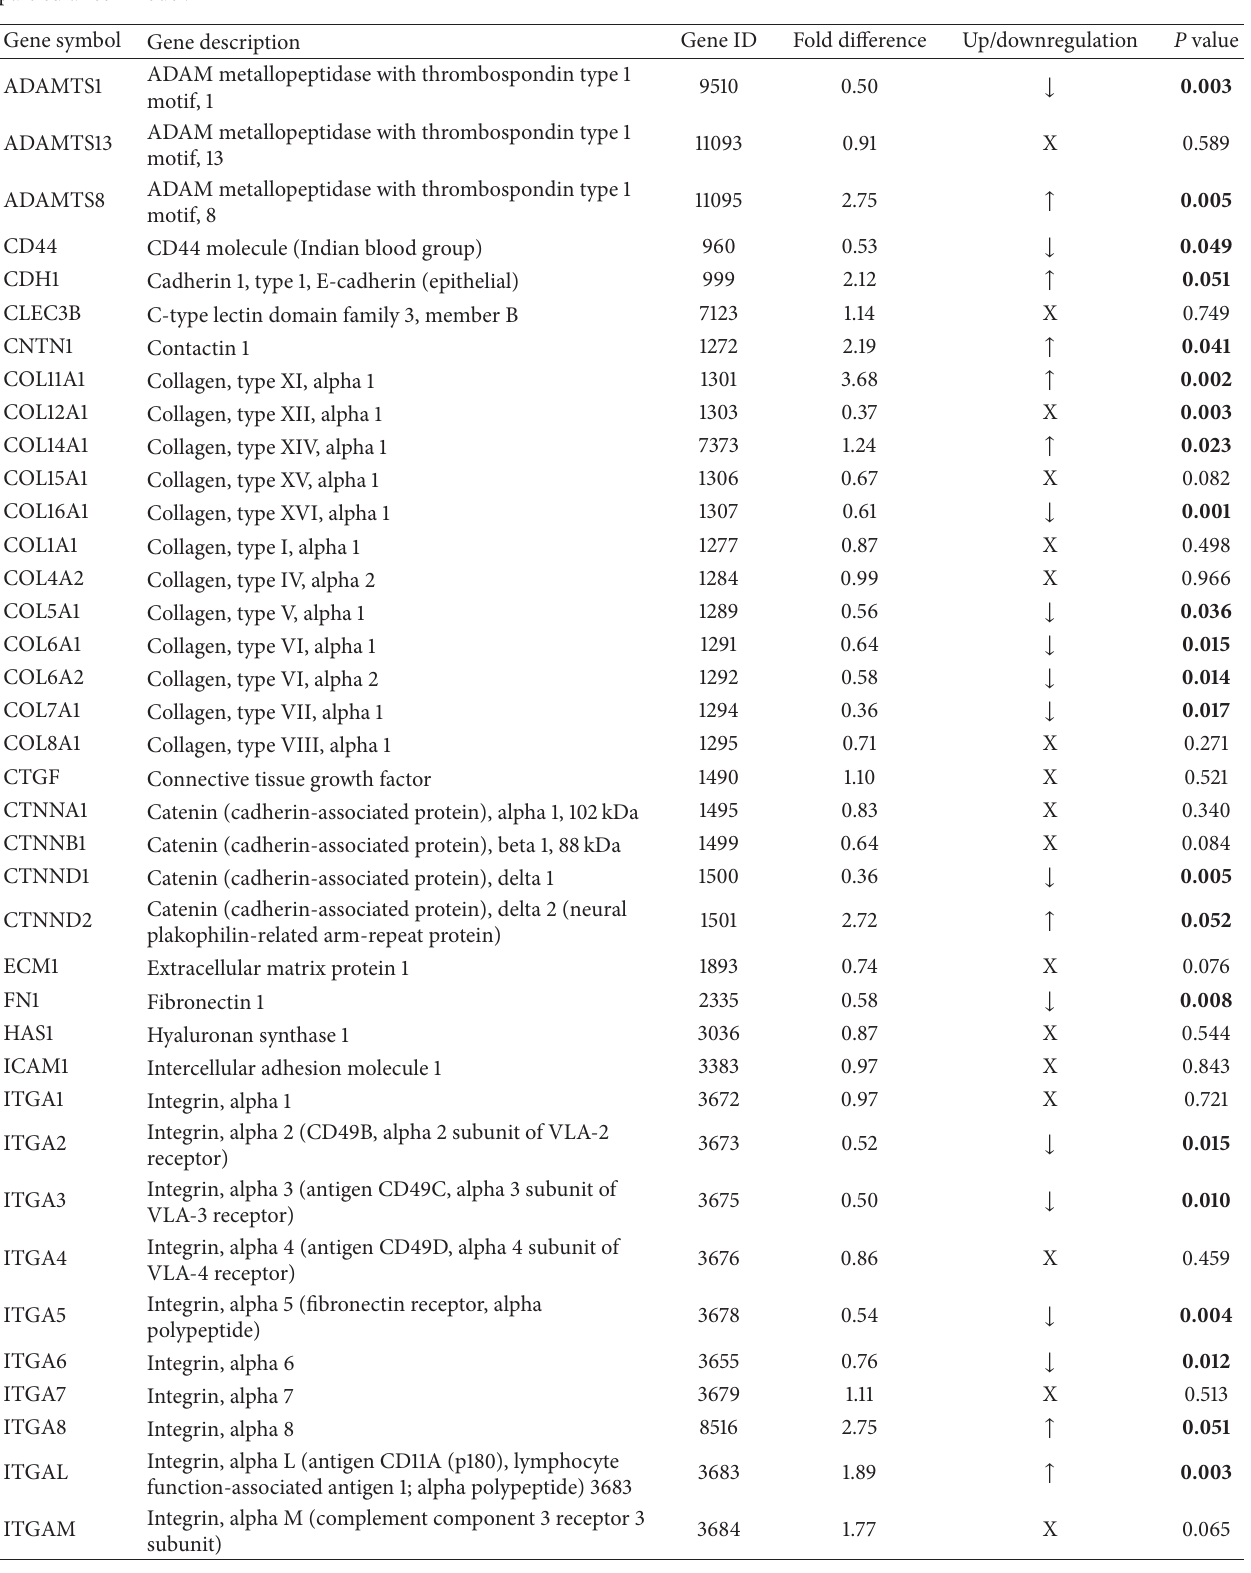
Table5:Geneexpressionprofileindiabeticwounded(DW)cellsirradiatedat660 nm.TotalRNAfromnonirradiatedDWcellsandirradiated DW cells were characterised in triplicate. A fold difference > 1 is considered as gene upregulation, while a fold difference < 1 is considered as gene downregulation. Fold differences are indicated as upregulation ( ↑ ) or downregulation ( ↓ ). X denotes the nonsignificant genes in that particular cell